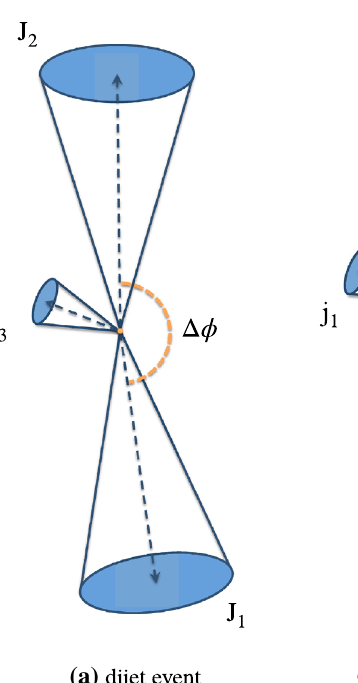
Fig. 1 Overview of the large- R jet reconstruction and calibration procedure described in this paper. The calorimeter energy clusters from which jets are reconstructed have already been adjusted to point at the event’s primary hard-scatter vertex